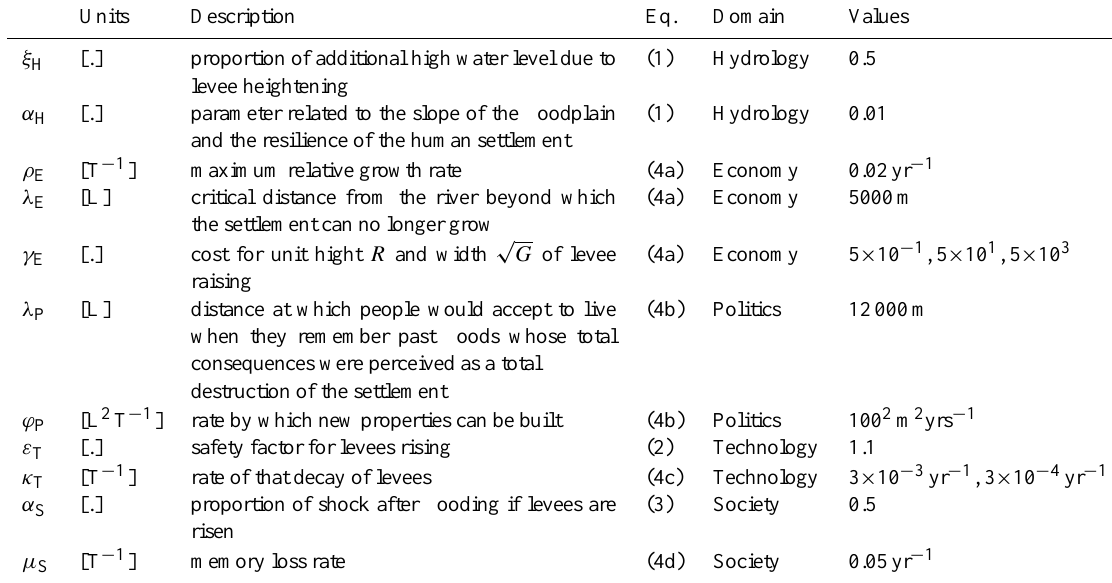
Table A2. Parameters of the dynamic system and their values in the examples of Sect. 3 (Figs. 4 and 5).